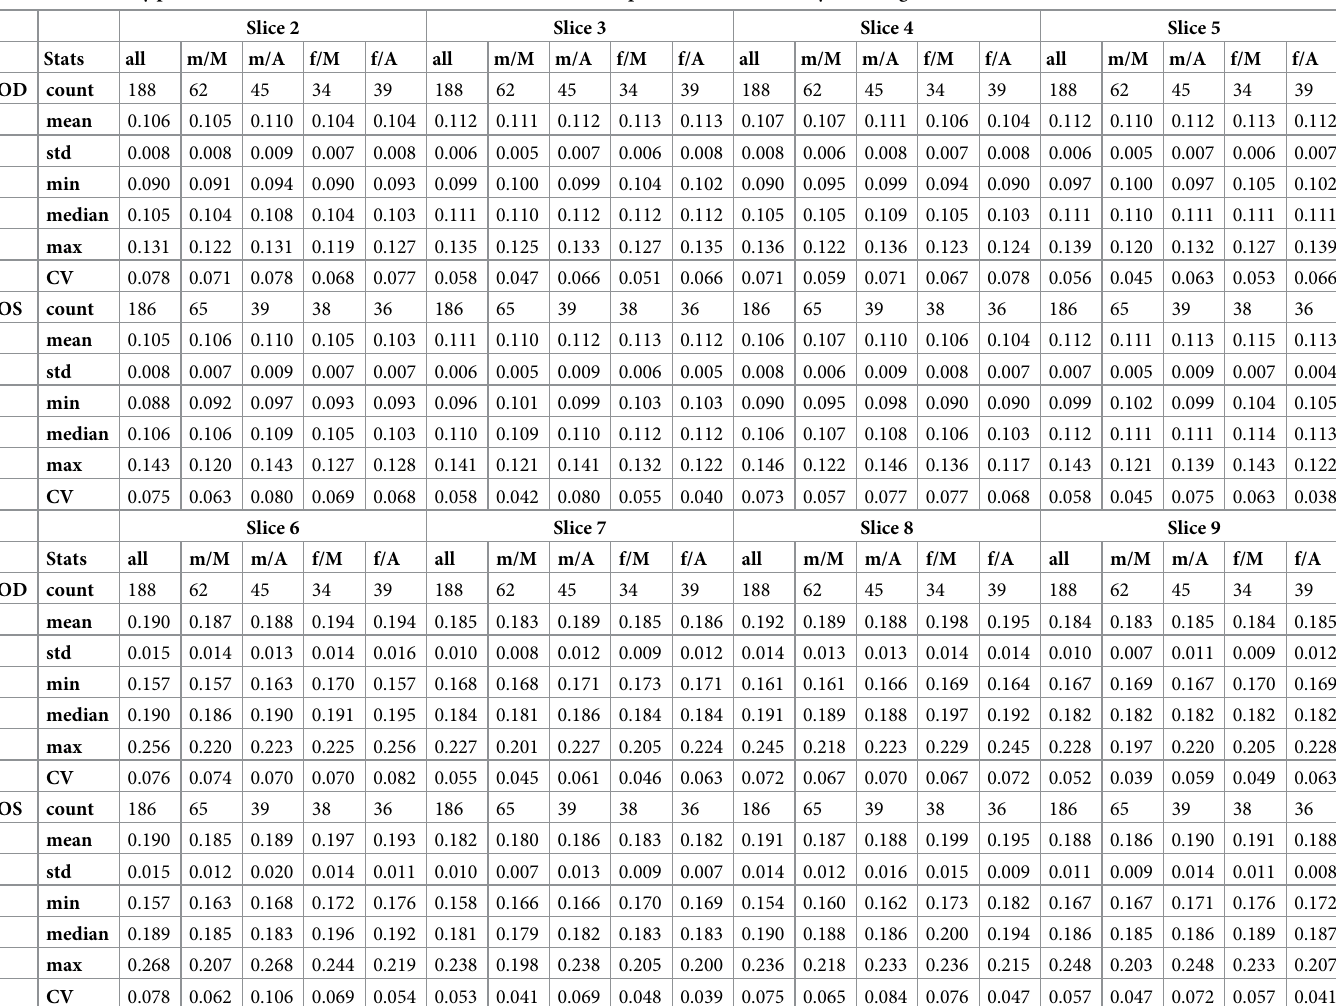
OD = oculus dexter, OS = oculus sinister, Stats = statistic, std = standard deviation, min = minimum, max = maximum, CV = coefficient of variation, m = male, f = female, M = Mauritius, A = Asian, values in mm 3 . Note that slice 1 is identical to zone